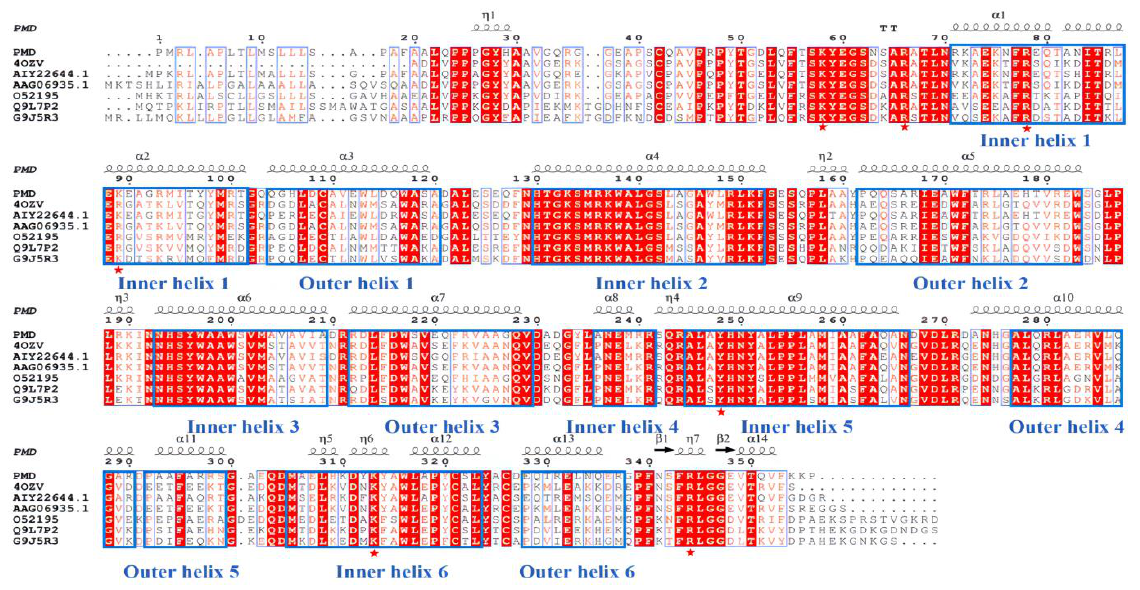
Figure 2. Multiple sequence alignment with structure prediction of the novel alginate lyase (PMD) and six reported polysaccharide lyase (PL) 5 family alginate lyases. The conserved amino acid residues are shown in red. The structure regions were labeled according to ( α / α )6-half-barrel rule (inner and outer layer). The mutated residues K58A, R66A, R78A, K89A, Y248A, K313A, and R344A are labeled with red pentastars.